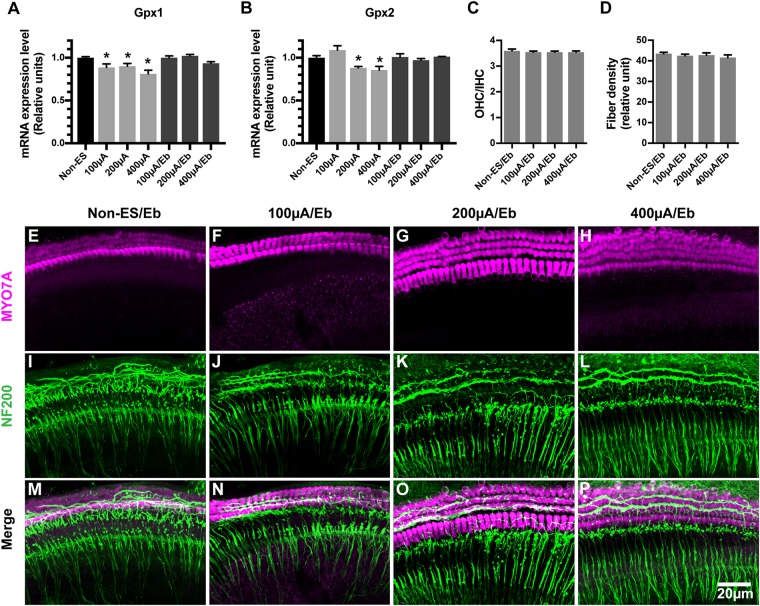
The mRNA expression level of GPx1 and GPx2 in cochlear explants decreased under ES and ebselen abolished this effect and the loss of SGN peripheral fibers. (A,B) ES treatment of 200 and 400 μA/48 h both significantly decreased the mRNA expression level of both GPx1 and GPx2 in explants while 100 μA/48 h-ES treatment only decreased the mRNA expression level of GPx1 (∗, GPx1: 200 μA, P = 0.0231; 400 μA, P = 0.0233; GPx2: 200 μA, P = 0.0484; 400 μA, P = 0.0228, when compared to non-ES group, n = 3 in each group, measurements were repeated three times). When the cochlear explants were treated with ES and 40 μM Ebselen at the same time, mRNA expression level of GPx1 and GPx2 was comparable to that in non-ES group (GPx1: 100 μA/Eb, P > 0.9999; 200 μA/Eb, P = 0.9738; 400 μA/Eb, P = 0.4027; GPx2: 100 μA/Eb, P > 0.9999; 200 μA/Eb, P > 0.9999; 400 μA/Eb, P > 0.9999 compared to non-ES group). When the cochlear explants were treated with 40 μM Ebselen, OHC/IHC ratio (C, P = 0.7997, P = 0.7629, P = 0.7639, in each group.) and the density of SGN peripheral fibers (D, P = 0.7860, P = 0.9025, P = 0.3482, n = 20 in each group.) in 100, 200, and 400 μA/48 h-ES groups had no significantly statistical difference from those in the non-ES group. (E–P) Representative images showed that there was no significant loss of hair cells (in magenta) and SGN peripheral fibers (in green) in ES-treated explants when they were maintained in medium with 40 μM Ebselen. Data represented the mean + SEM.